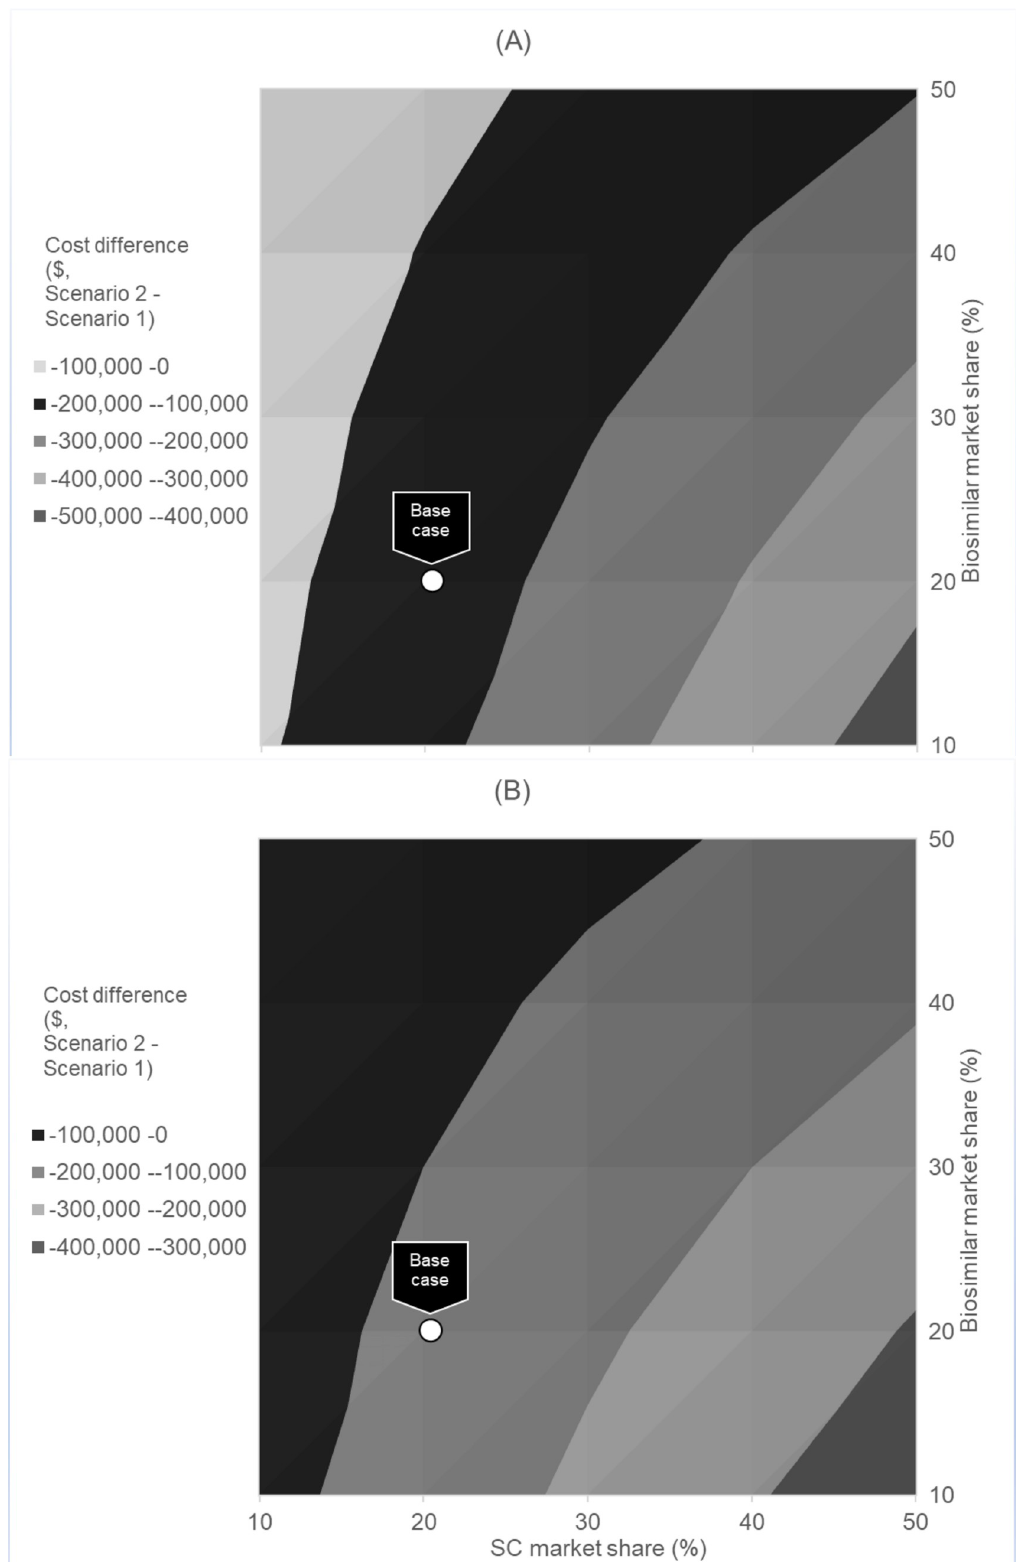
Fig 2. Expected cost savings given market share shift in SC and biosimilar IV, all patients. https://doi.org/10.1371/journal.pone.0261336.g002 PLOS ONE | https://doi.org/10.1371/journal.pone.0261336 January 24,